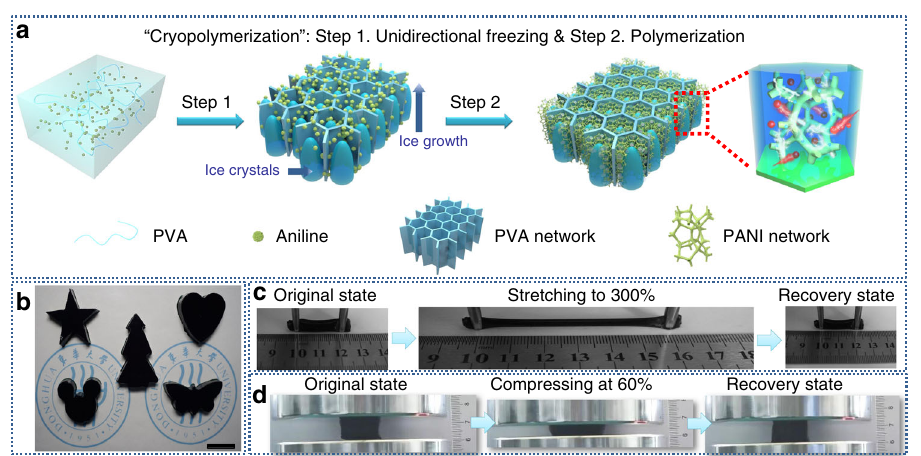
Fig. 1 Fabrication and schematic of the anisotropic hybrid hydrogels. a Schematic diagram of the preparation procedure of the anisotropic polyvinyl alcohol/polyaniline hydrogel (APPH). b Photograph of the APPH with diverse shapes. Scale bar: 2 cm. c Photograph of fi ber-shaped APPH under stretching/recovering. d Photograph of cylinder-shaped APPH under